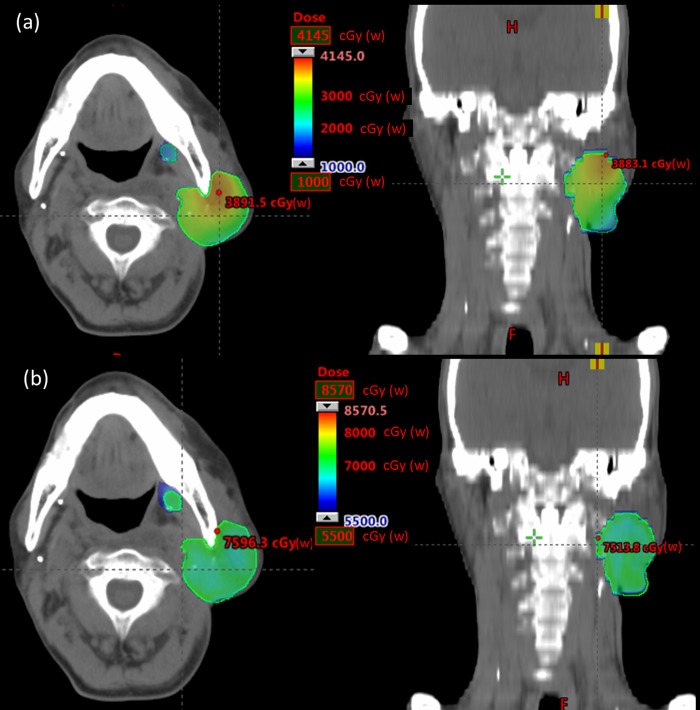
Representative isodose curves of GTV for the BNCT alone (a) in axial and coronal views and BNCT+IMRT (b) plans in axial and coronal views for a recurrent oropharyngeal cancer.